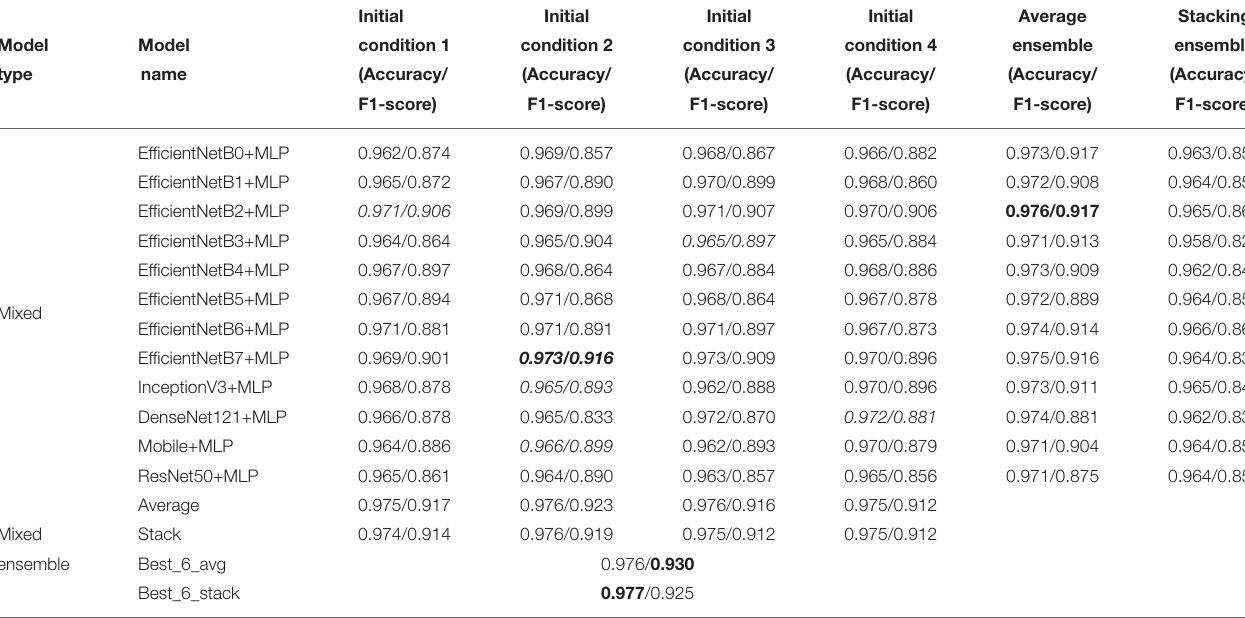
TABLE 3 | Mixed model test accuracy and F1-score of the individual models across four different initial conditions.